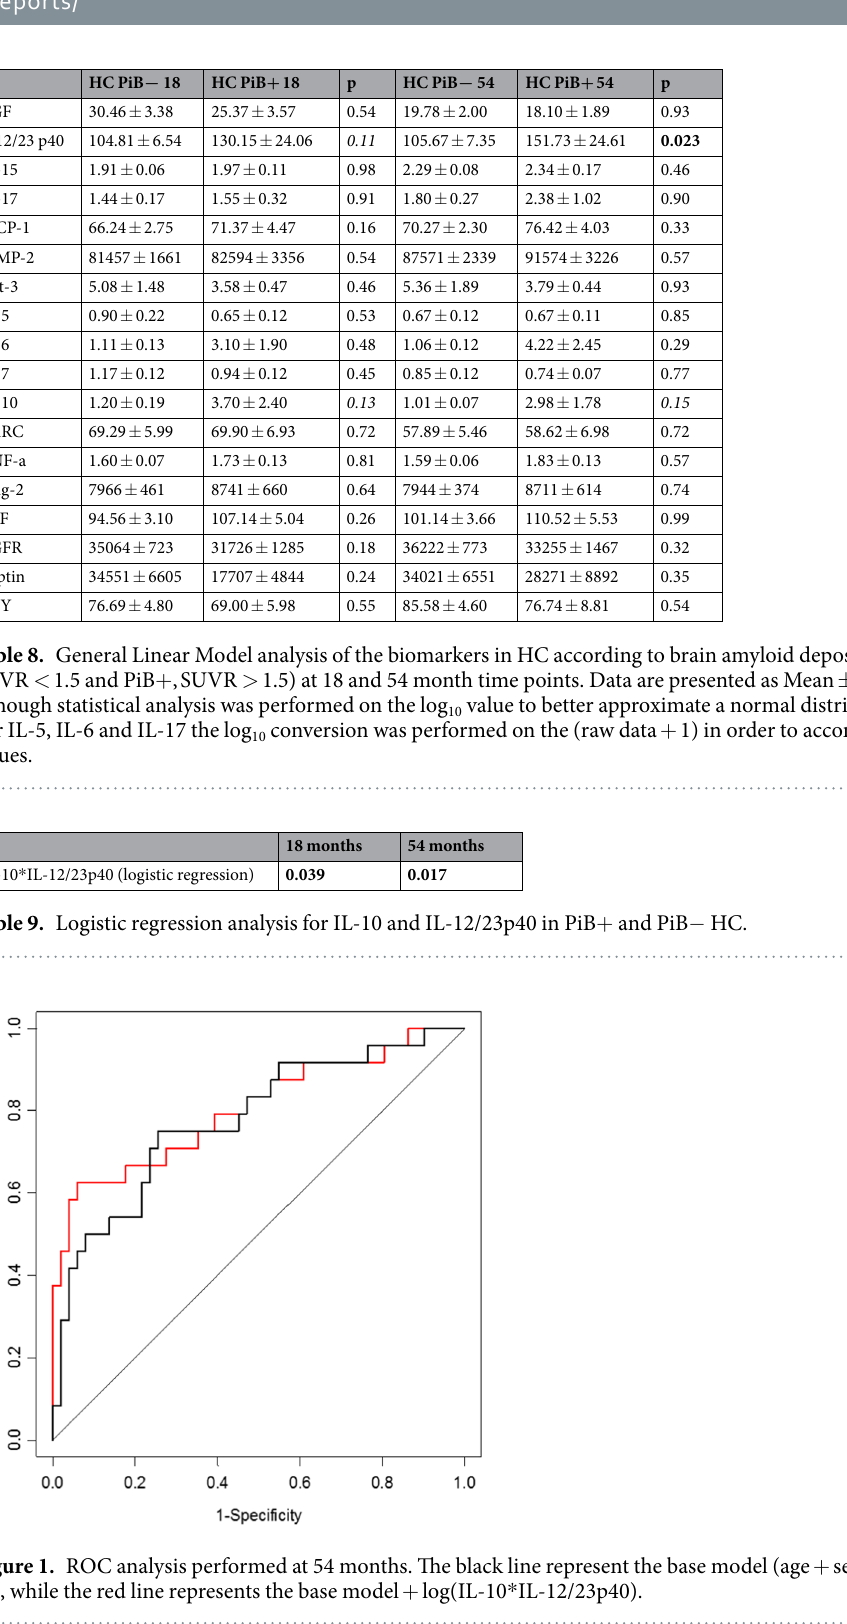
when including the IL-10 * IL-12/23p40 to the base model (age + sex + APOE ε 4) for which the AUC = 0.779 (Fig. 1). Similar results were obtained when evaluating our HC at 18 months (Base model AUC = 0.787; Base model + log(IL-10 * IL-12/23p40) AUC = 0.802, data not shown). We also evaluated the levels of the same biomarkers in all HC at 18 months based on their classification at 54 months, comparing the non-converter participants, who did not develop AD at 54 months, versus those who did